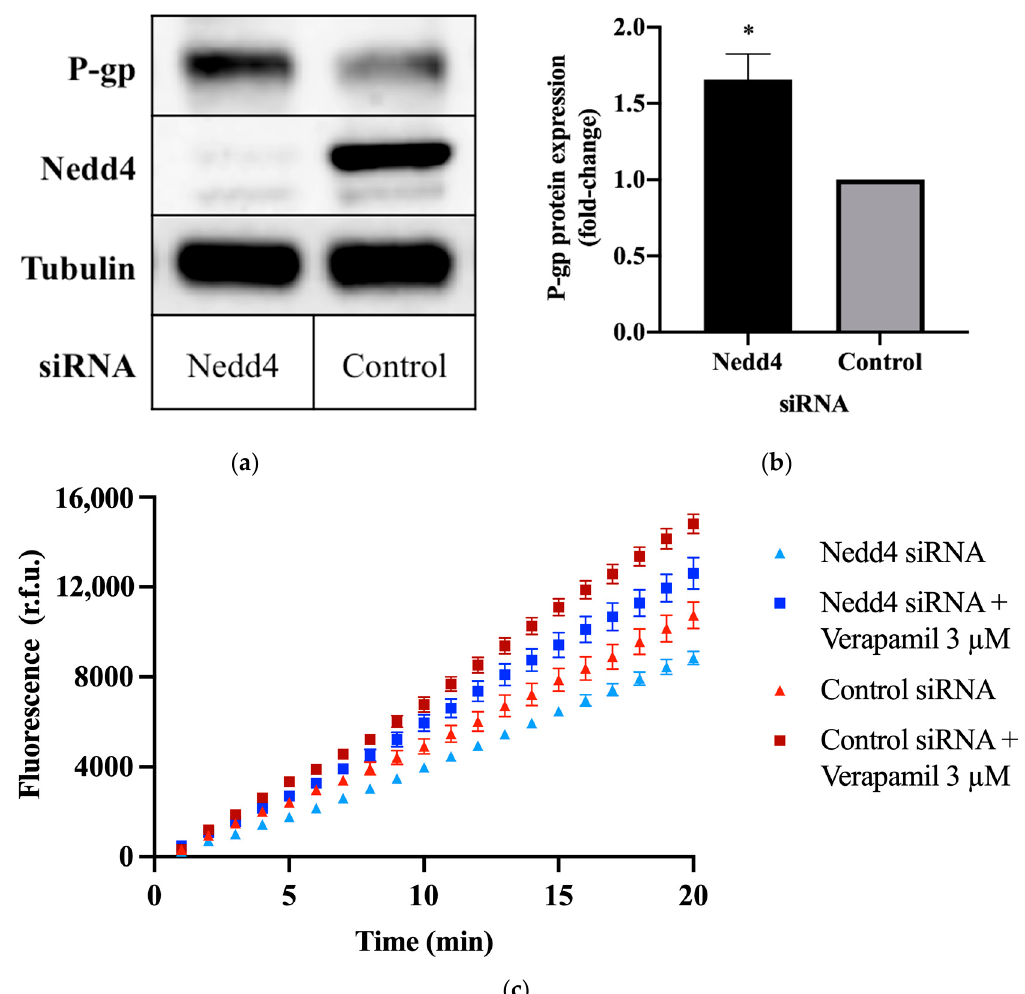
Figure 1. Effect of Nedd4 knockdown on P-gp protein expression and activity in CHO-APP cells. ( a ) CHO-APP cells were transfected with Nedd4 siRNA or universal control for 48 h. Immunoblots are representative of three independent experiments. The housekeeping protein, tubulin, was used as a loading control. ( b ) Relative expression of P-gp protein in lysates of CHO-APP cells treated with Nedd4 siRNA or universal control. P-gp signal intensities were normalised to tubulin. Data (mean ± SEM of three independent experiments) were statistically analysed using the two-tailed Student’s t -test. * p ≤ 0.05 compared with control. ( c ) Intracellular accumulation of fluorescent calcein in CHO-APP cells transfected with Nedd4 siRNA or universal control for 48 h. Verapamil (3 μ M), a P-gp inhibitor, was used as a positive control and added after the 48 h siRNA transfection and immediately before the calcein-AM assay was conducted. Data (mean ± SEM) are representative of three independent experiments, each performed with eight biological replicates.